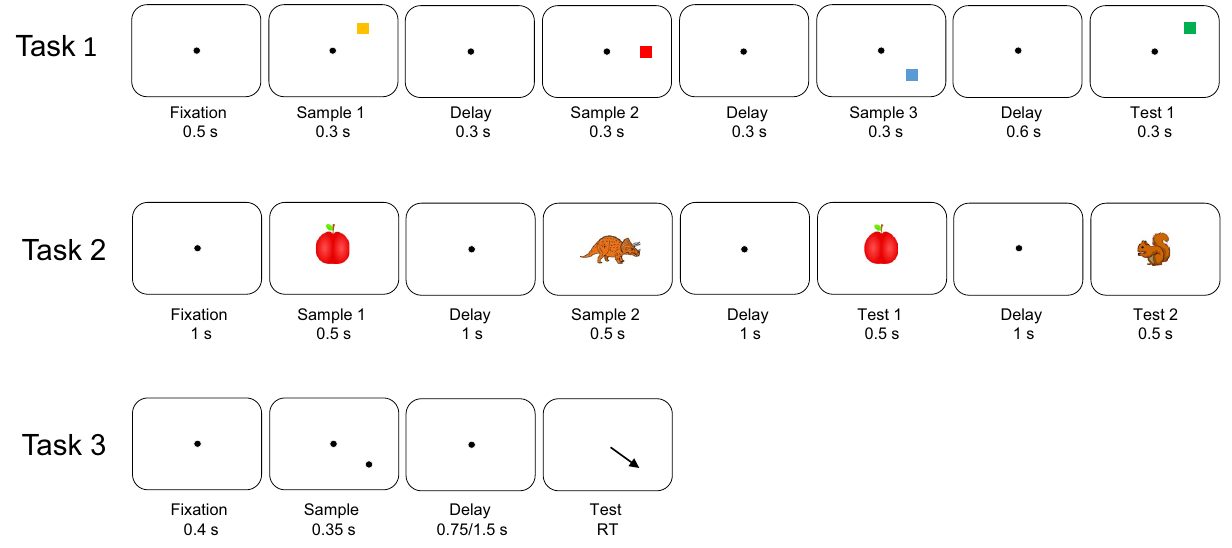
Figure 1. Task structure of the 3 working memory tasks. Top : Structure of Task 1. The monkeys were presented with a sequence of 3 colored squares in 3 distinct positions. After a brief delay, the monkeys were exposed to a new sequence of up to 3 squares. They reported with a saccade to the first square that had changed color between sample and test sequences (one of the squares always changed, in the above case the first). Middle: Structure of Task 2. The monkeys were presented with a sequence of 2 objects foveally. After a brief delay, the monkeys were exposed to a new sequence of 2 objects. They reported by lifting a bar if the test sequence did not match the sample sequence. Bottom: Structure of Task 3. Delayed saccade task with 2 possible delay lengths. On 6/7 trials, there was a 0.75 s delay, on the rest there was a 1.5 s